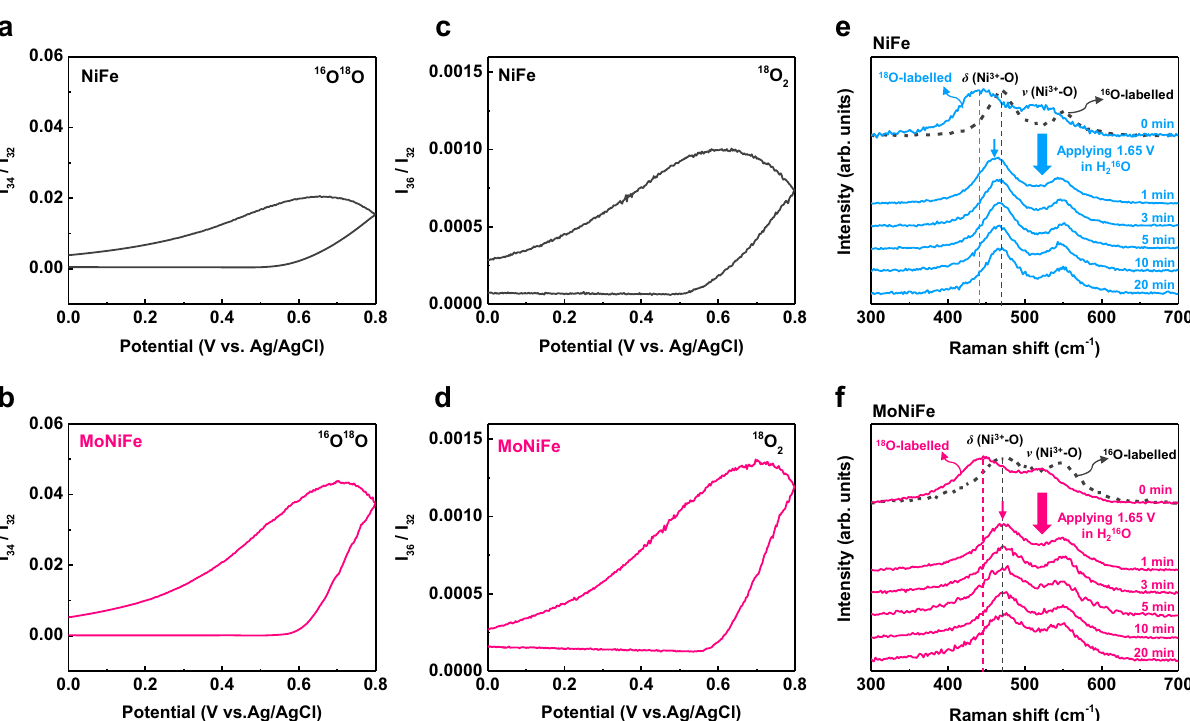
Fig. 3 Evidence of lattice oxygen participating in OER provided by 18 O isotope-labeling experiments. Mass spectrometric cyclic voltammograms results showing different gaseous products content of OER reaction as a function of applied potential for the 18 O-labeled samples: 16 O 18 O for a NiFe (oxy) hydroxide and b MoNiFe (oxy)hydroxide, 18 O 2 for c NiFe (oxy)hydroxide and d MoNiFe (oxy)hydroxide. The contents of all the species were normalized by the amount of 16 O 2 in the reaction products. Quasi in-situ Raman spectra of e 18 O-labelled NiFe and f 18 O-labelled MoNiFe (oxy)hydroxides after being applied a positive potential of 1.65 V (vs. RHE) in 1.0 M KOH with H 2 16 O for different time (1 min to 20 min). The Raman spectra of 16 O-labelled samples were shown in black dash lines for